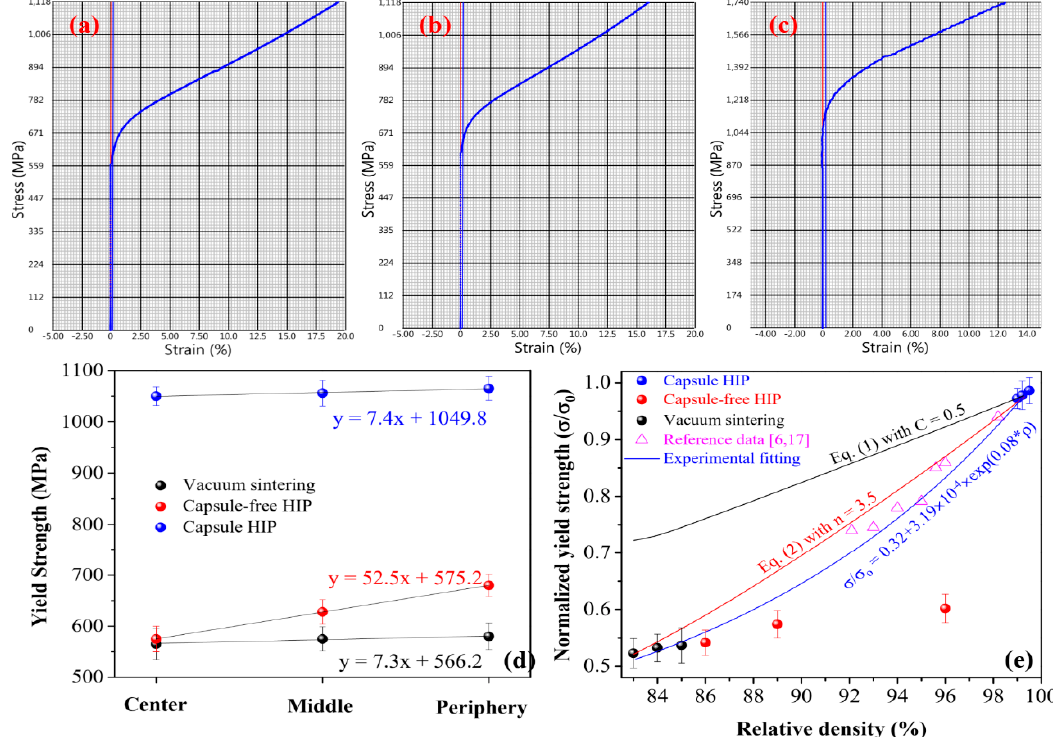
Figure 10. True stress–strain compression curves at middle position of Ti6Al4V alloy sintered by di ff erent techniques ( a ) vacuum sintering, ( b ) capsule-free HIP, and ( c ) capsule HIP, and ( d ) yield strength of Ti6Al4V alloy versus different positions of the specimens and ( e ) normalized yield strength of Ti6Al4V alloy sintered by different techniques as a function of the relative density.